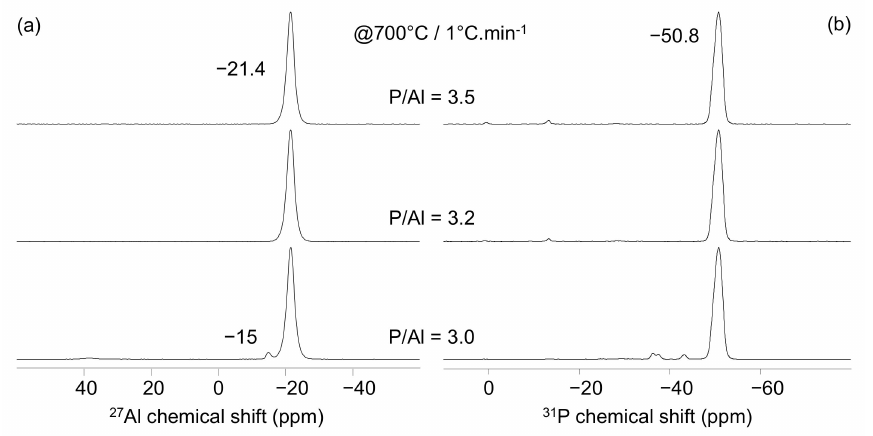
Figure 2. 27 Al ( a ) and 31 P ( b ) MAS-NMR spectra obtained at 700 ◦ C on Al/P = 3 (bottom), 3.2 (middle), and 3.5 (top)